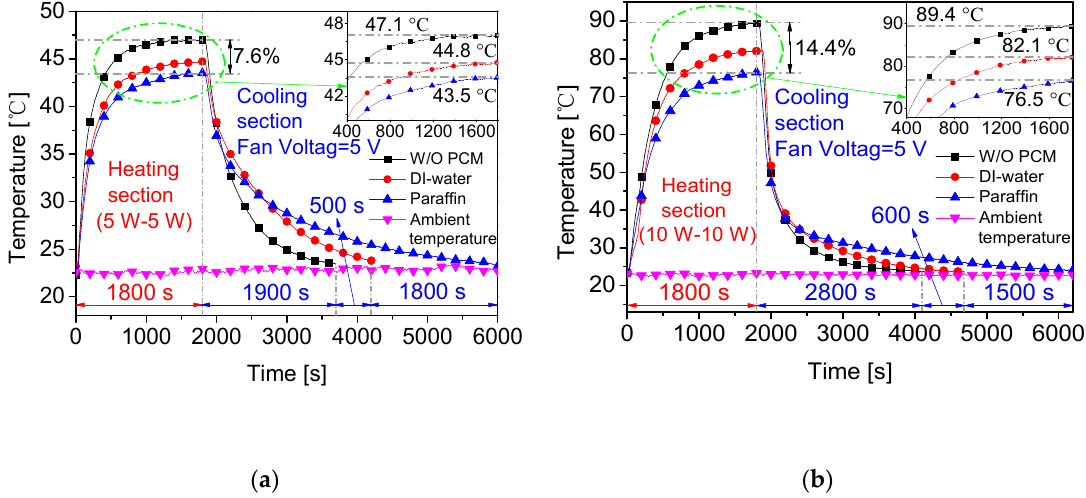
Figure 3. Temperature variations under different heating powers (heat source 1 power–heat source 2 power): ( a ) 5 W–5 W and ( b ) 10 W–10 W.